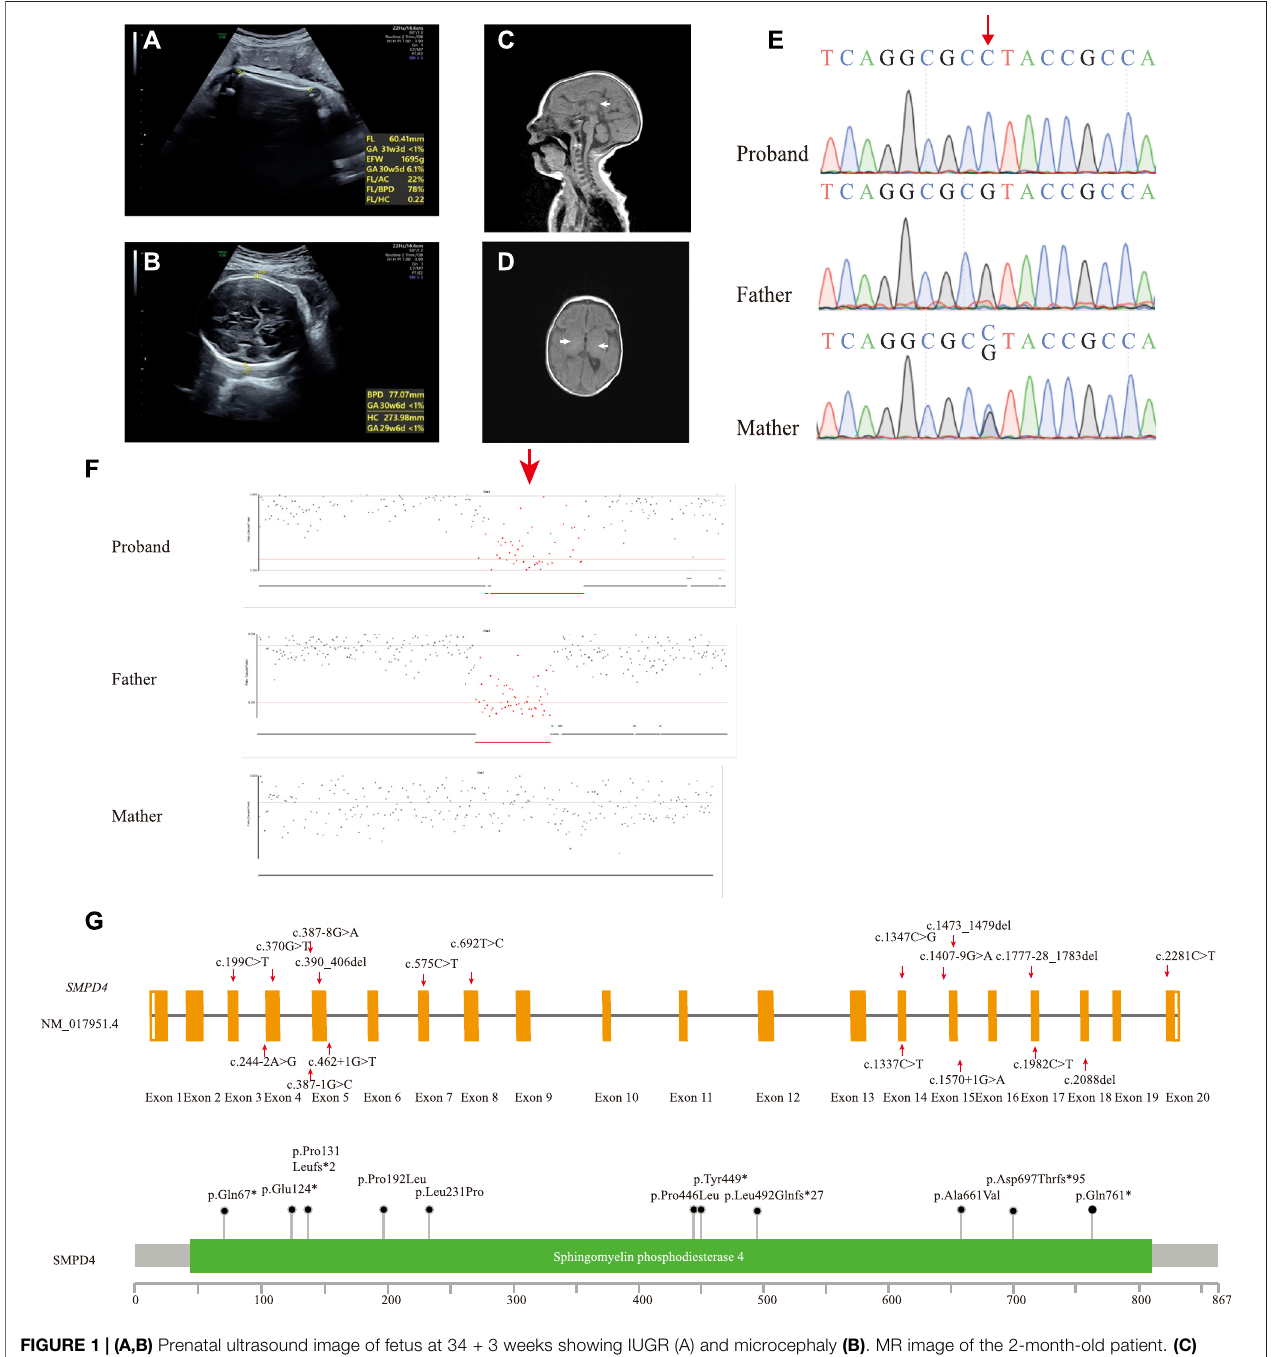
FIGURE 1 | (A,B) Prenatal ultrasound image of fetus at 34 + 3 weeks showing IUGR (A) and microcephaly (B) . MR image of the 2-month-old patient. (C) T1-weighted image (T1WI) of median sagittal section showing thin corpus callosum, splenium, and unclear body (white arrow). (D) T1WI axial section absent of high signal of bilateral posterior limbs of the internal capsule showing hypomyelination (white arrow). (E) Sanger sequencing results of the proband and her parents. The single-nucleotide substitution is indicated by the red arrow. (F) Deletion in the proband was inherited from the father (red arrow). (G) Schematic presentation of linear SMPD4 transcript (NM_017951.4) (up) and protein (down) with all variants